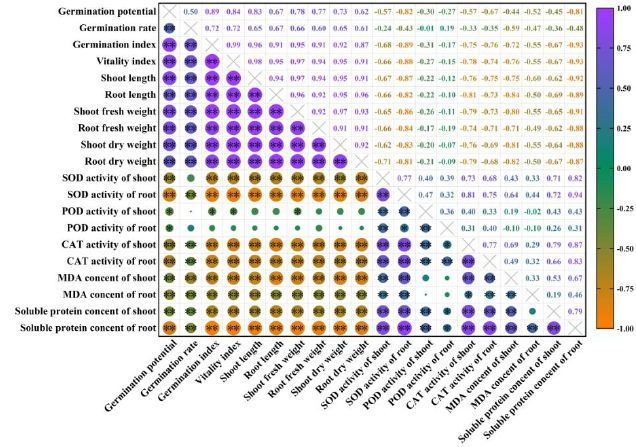
Figure 10. Correlational analysis of seed germination and physiological indices of rice under high temperature stress and melatonin concentration treatment. **: significant at the 0.01 probability level ( p < 0.01); *: significant at the 0.05 probability level ( p < 0.05).